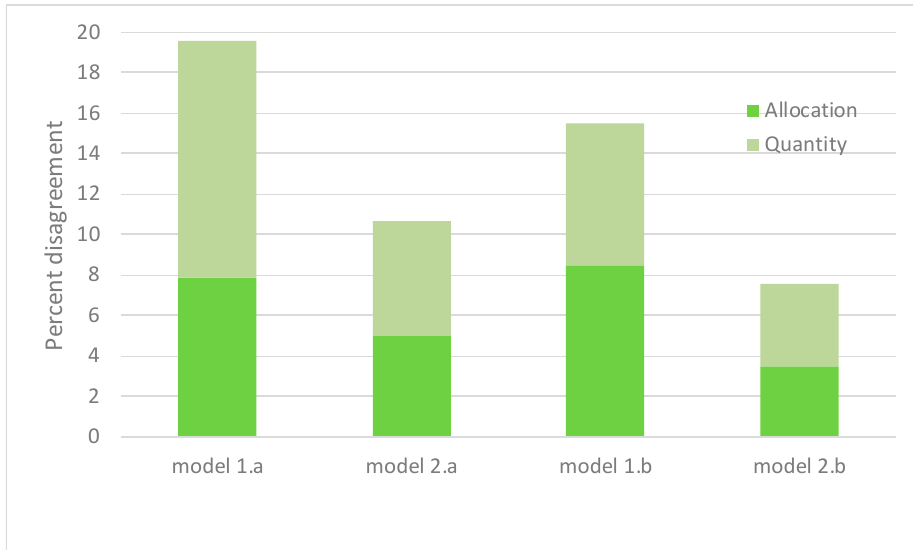
Figure 5. Maps showing the classification results of model 2.a and model 2.b are XGBoost and RF, respectively, with vegetation and topographic indices added to the Sentinel-2 reflectance bands, panel ( A , B ), respectively. The boundaries present the different land tenures present within the study